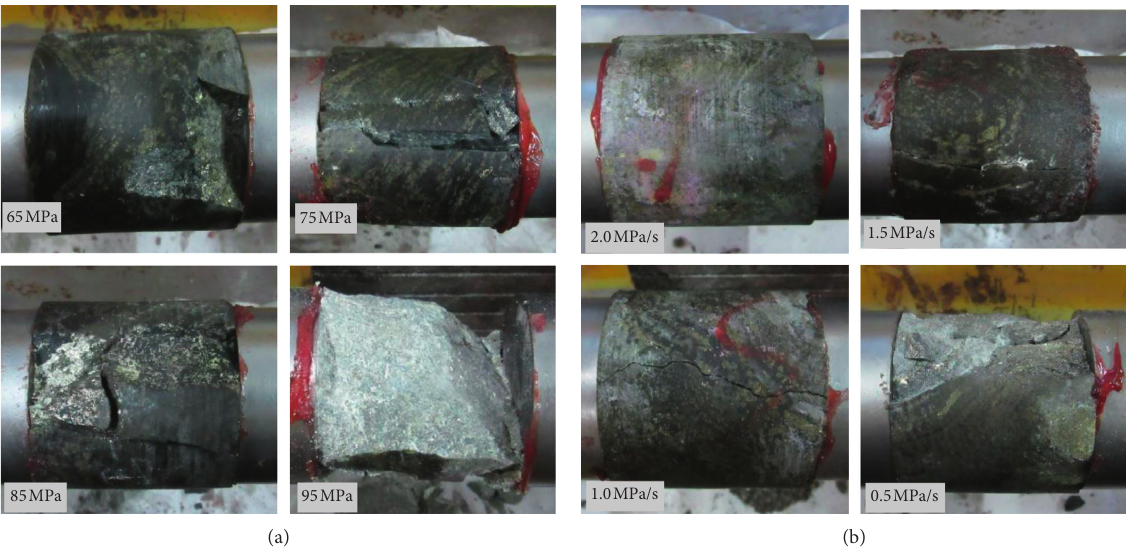
Figure 9: The damage states of rocks during the impact process. (a) The unloading rate was 0.5MPa/s and it is the seventh impact. (b) The preloaded axial pressure is 85MPa and it is the 10th